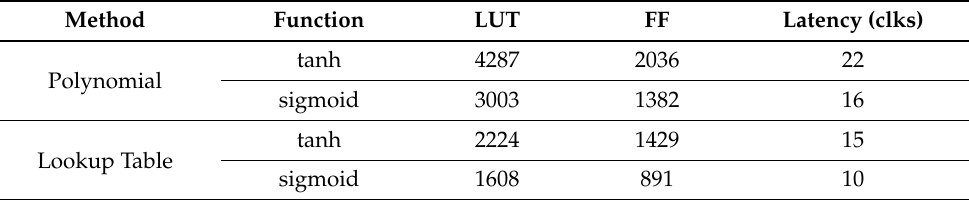
Table 1. Resource usage and latency comparison between polynomial approximation and lookup table method.